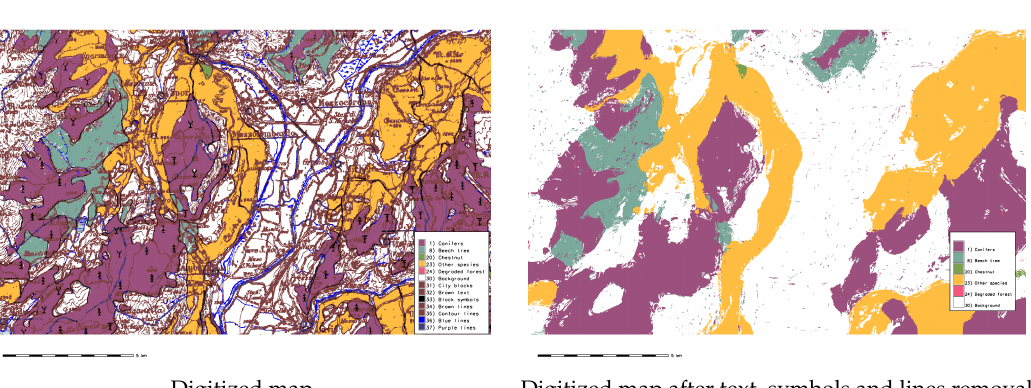
Figure 17. Digitized maps for the Italian Kingdom Forest Map (IKFM) (particular), SWV voting system.